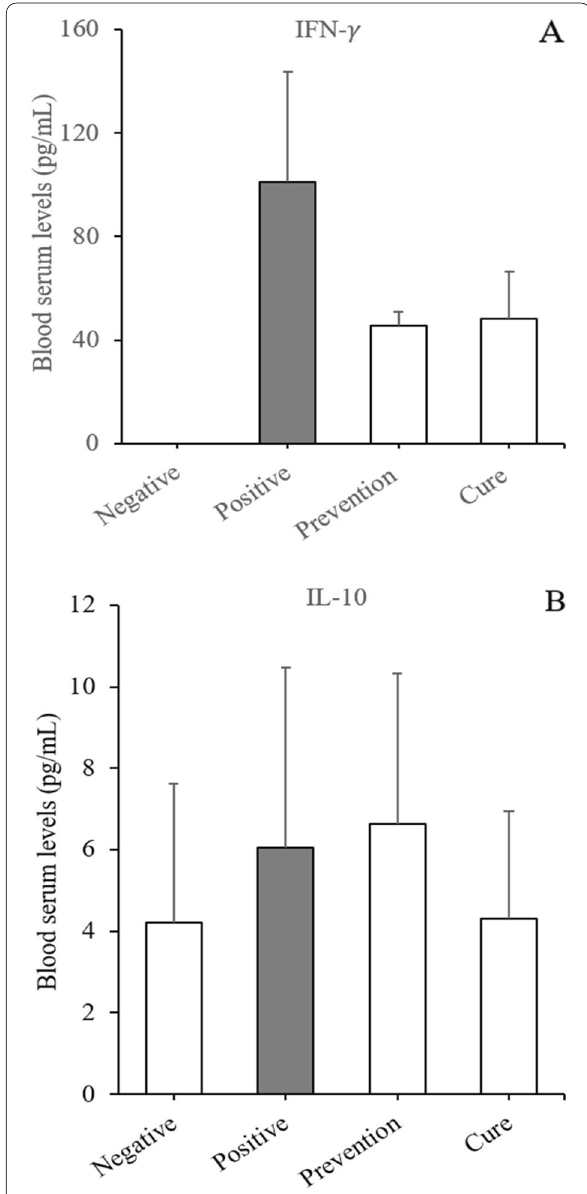
Fig. 4 Cytokine levels in cecal contents of mice with and without Citrobacter rodentium infection. A Interferon (IFN) gamma levels increased in all mice infected with this bacterium, with the highest levels seen in the positive control group and the medium levels in the two groups that received immobilized L. plantarum ( B ) Increases in the levels of interleukin (IL)-10 were observed in the positive control and prevention groups. The results are shown as the mean